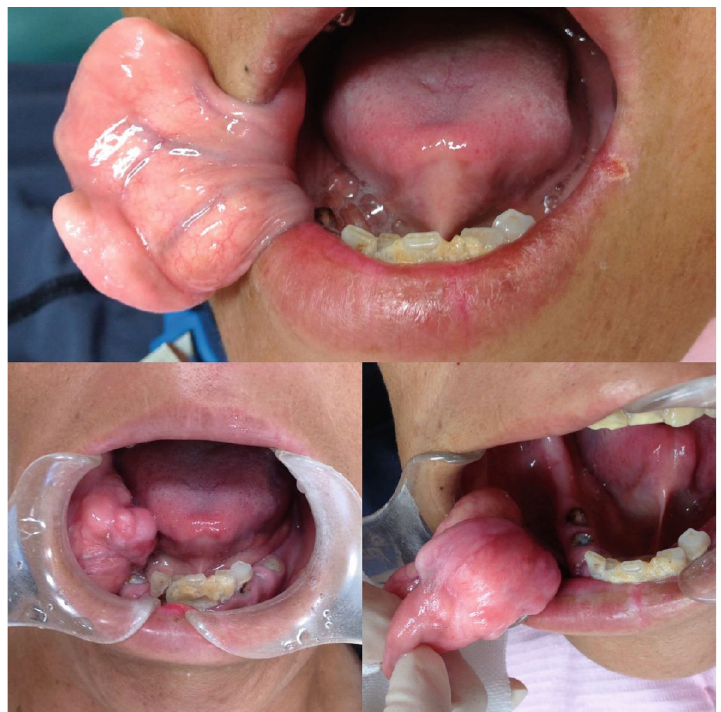
Figure 1: Intraoral photograph of the tumor. A pinky smooth, elastic, soft, circular, and pedunculated tumor-like lesion, with a diameter of approximately 40mm, on the right buccal mucosa.